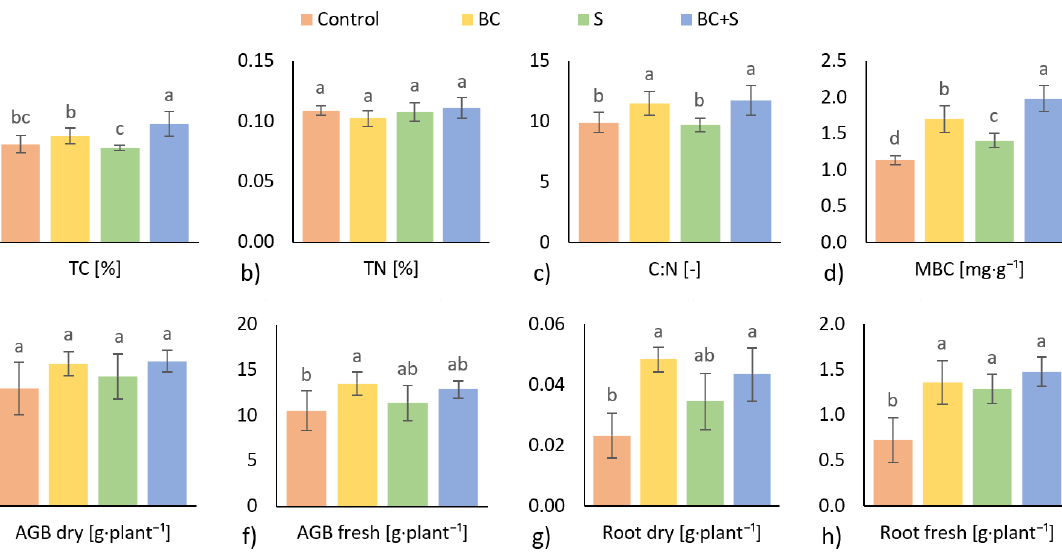
Figure 1. Total soil carbon ( a ) and nitrogen ( b ), C:N ratio ( c ), microbial biomass carbon ( d ); dry ( e ) and fresh ( f ) aboveground biomass (AGB), dry ( g ) and fresh ( h ) root biomass; tested treatments: BC—biochar, S—sulphur, BC + S—biochar and sulphur. Mean ± SD. The different letters express the results of ANOVA Tukey’s HSD Posthoc Test—the statistical differences at significance level p ≤ 0.05.